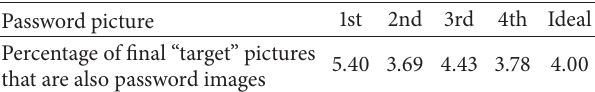
Table 1: Percentages of final “target” pictures that are also password pictures.